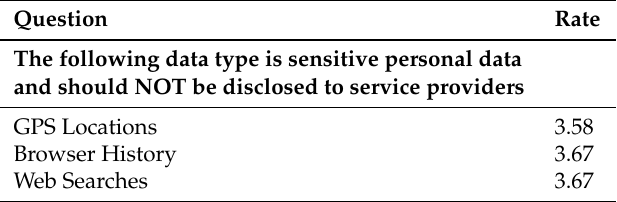
Table 3. User feedback about the three types of personal